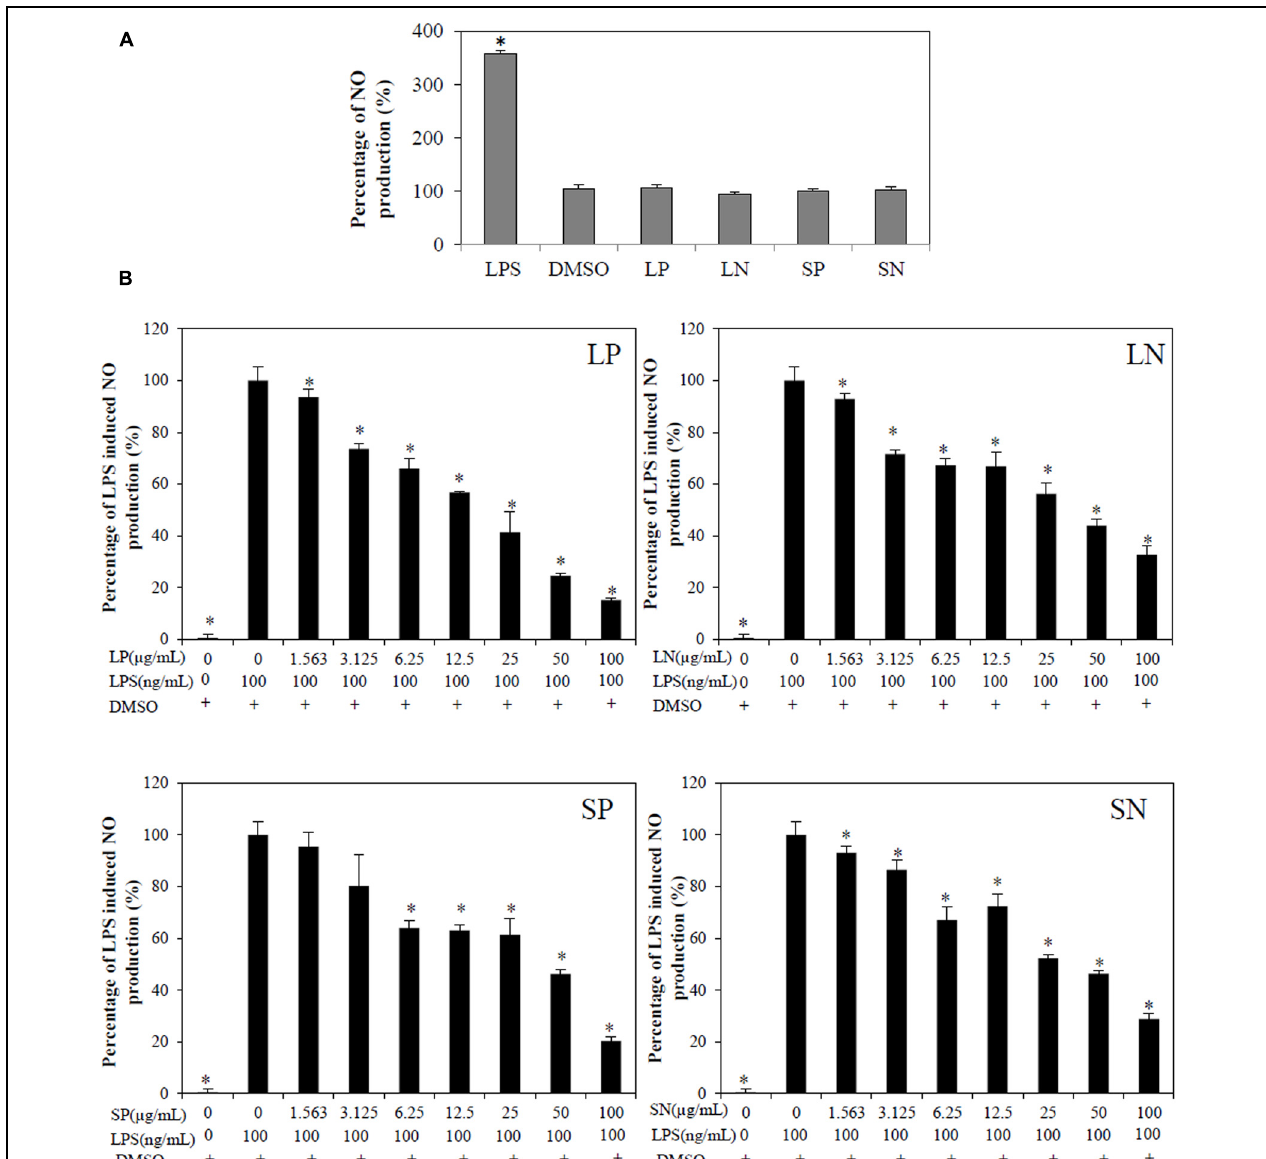
FIGURE 2 | Effect of C. nutans extracts on NO production in RAW264.7 cells. (A) As compared to cells treated with 0.1% DMSO, cells treated with 100 μ g/mL of LP, LN, SP, SN failed to induce significant NO production, while cells treated with 100 ng/mL of LPS induced significant NO production ( ∗ p < 0.05, one-way ANOVA post hoc Dunnett’s t -test). (B) Cells were treated with various concentrations of extracts (1.5625–100 μ g/mL) or 0.1% DMSO for 1 h followed by 18 h of LPS induction (100 ng/mL). Statistical significant difference from LPS induction are indicated as ∗ p < 0.05 by one-way ANOVA post hoc Dunnet’s t -test. Each value represents means ± SD from three independent